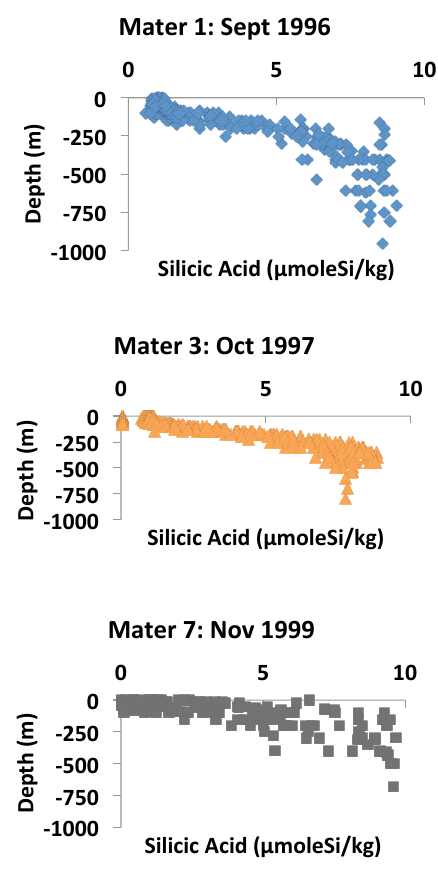
Figure 4. Vertical distribution of dissolved silicic acid in the water column of a series of stations across the Straits of Sicily sampled as part of the MTP-MATER programme (1996–1999) (Data from Lavezza et al.,